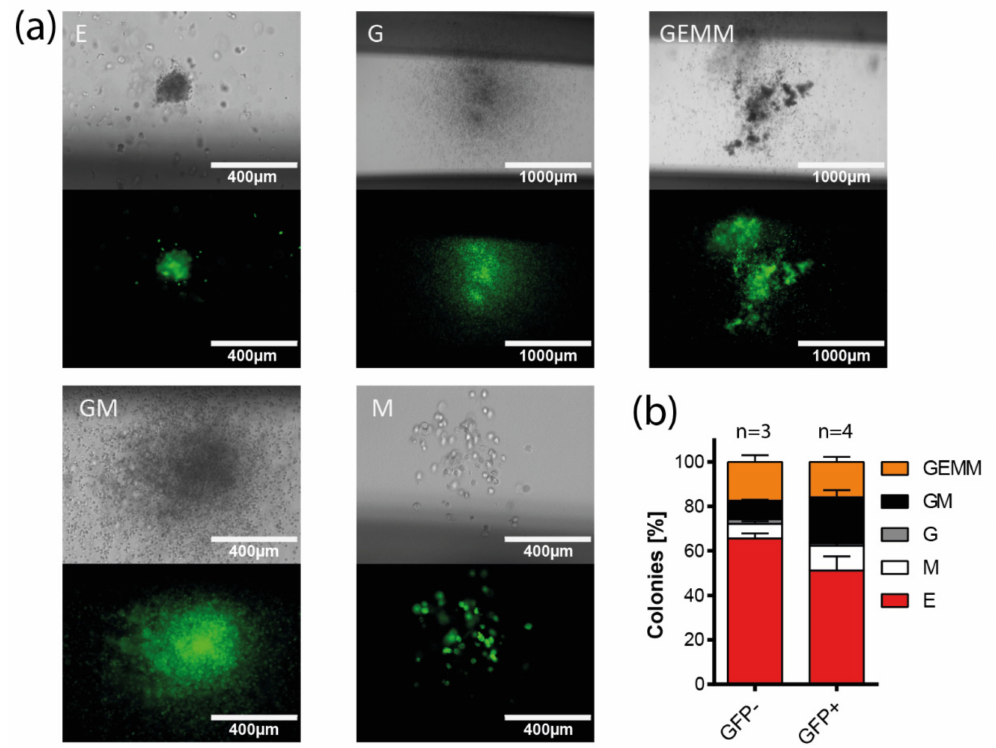
Figure 3. Distribution of HIV-1 infection in colonies formed from cord-blood-derived Lin − cells. ( a ) Fluorescence images of GFP + colonies obtained in a colony-formation assay (day 14), in which cord-blood-derived Lin − cells were transduced with HxB2 Env-pseudotyped GFP reporter virus. (CFU: colony-forming unit; E: erythrocyte colony; G: granulocyte colony; mixed GEMM: granulo- cyte/erythrocyte/macrophage/megakaryocyte colony; GM: granulocyte/macrophage colony; M: macrophage colony) ( b ) Quantitative analysis of one colony-formation assay (d14), in which cord- blood-derived Lin − cells were transduced with HxB2 Env-pseudotyped GFP reporter virus. The relative frequency of individual colony types is shown for transduced (GFP + ) and non-transduced (GFP − ) colonies. Two-tailed t -tests comparing GFP − vs. GFP + colony types show a significant difference for the amount of GM colonies ( p = 0.0218). n represents the number of individual mea- surements; 413 GFP − colonies and 74 GFP + colonies were analyzed; mean and standard error of the mean are